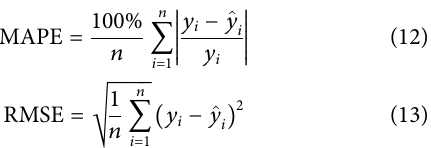
Frontiers in Energy Research |